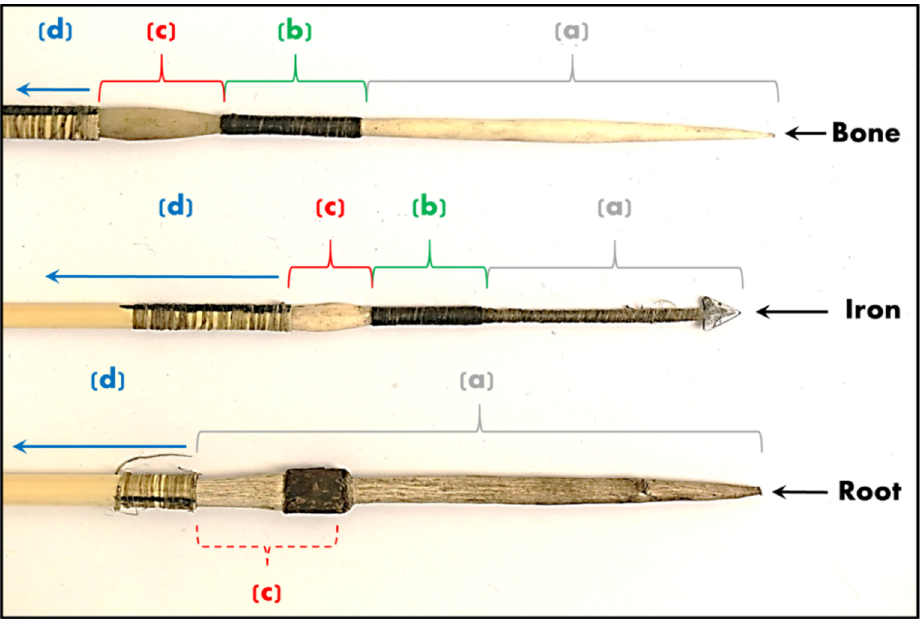
Figure 1. Different sections of the Ju|’hoansi arrows: ( a ) the arrowhead, which may be made of giraffe shin bone, ductile iron or Rhus tenuinervis root; ( b ) the composite link-shaft that is only present in the iron and bone arrowhead arrows—this link-shaft is radially reinforced with giraffe tendon and glued to the surface of the reed; ( c ) the balance—made from bone in both the bone and iron type arrows, but carved into the structure of the root type arrowhead; and ( d ) the main shaft of the arrow, reinforced radially in the area where the balance is inserted.